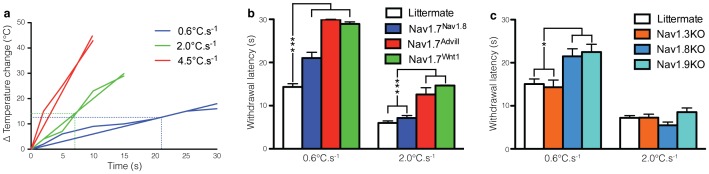
Comparison of different transgenic mice reveals stimulus-intensity specific responses to noxious thermal stimuli.Behavioural responses of different Nav1.7 tissue-specific knockouts to the Hargreaves test applied to the hindpaw. (a) Nav1.7Nav1.8 mice (blue columns, n = 14), Nav1.7Advill mice (red column, n = 7) and Nav1.7Wnt1 mice (green column, n = 12) all show a behavioural deficit in response to the Hargreaves test at a heat ramp of 0.6°C.s−1 in comparison to littermate mice (white columns, n = 27), however only Nav1.7Advill and Nav1.7Wnt1 mice show a behavioural deficit in response to the Hargreaves test at a heat ramp of 2.0°C.s−1. (b) Nav1.8KO mice (light blue column, n = 6) and Nav1.9KO mice (turquoise column, n = 10) but not Nav1.3KO mice (orange column, n = 6) show a significantly increased withdrawal latency to the Hargreaves test at a heat ramp of 0.6°C.s−1 in comparison to littermate mice (white columns, n = 18), however this significant increase is lost the when the Hargreaves test is conducted using a heat ramp of 2.0°C.s−1. Data analysed by two-way analysis of variance followed by a Bonferroni post-hoc test. Results are presented as mean ± S.E.M. * P<0.05 and *** P<0.001 (individual points).